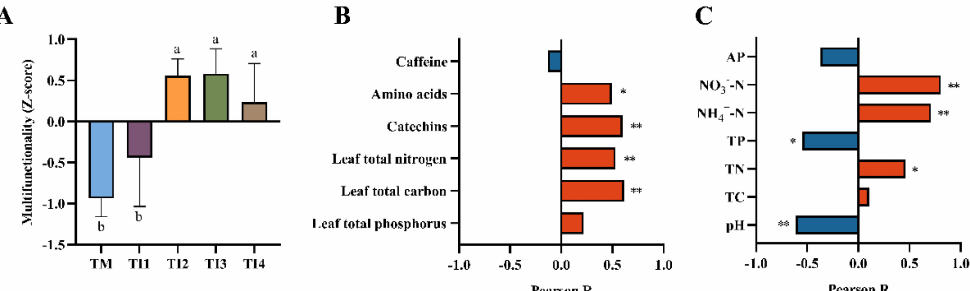
Figure 1. Ecosystem multifunctionality and its correlated indexes: ( A ) soil ecosystem multifunction- ality (Z-scores) in different treatments. Pearson correlations of ecosystem multifunctionality with ( B ) tea-plant performance and ( C ) soil properties. Different letters represent significant differences between treatments ( p < 0.05). Treatments include tea-plant monoculture (TM), tea intercropping with soybean (TI1), tea intercropping with soybean—milk vetch (TI2), tea intercropping with soybean—red clover (TI3), and tea intercropping with soybean—smooth vetch (TI4). Significant correlations were labeled as follows: ** p < 0.01; * p <